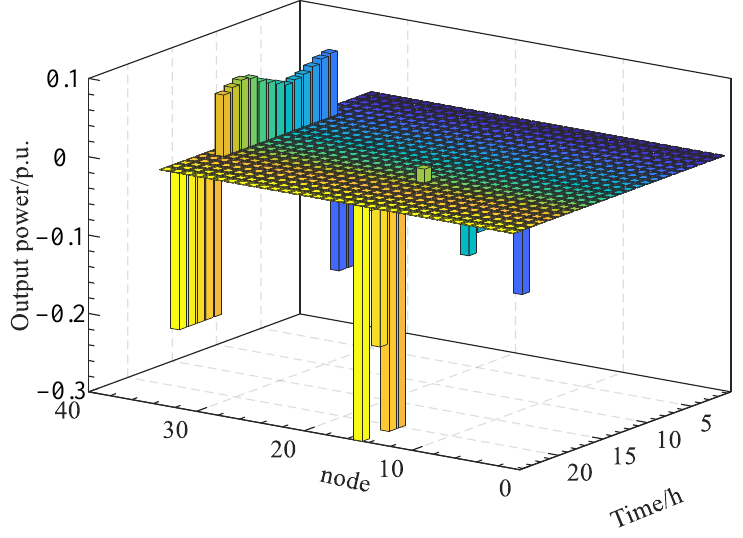
Figure 10. ESS Spatial and temporal distribution of power output.